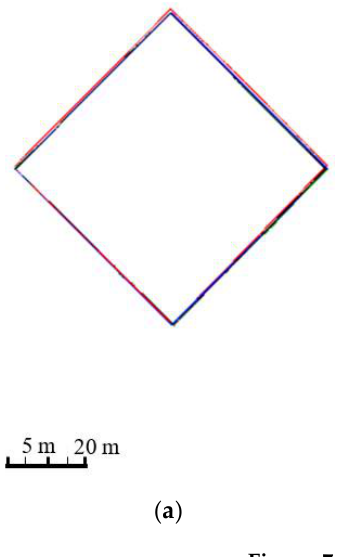
Figure 7. Reference and DR, GA1, GA2 estimated paths of vehicle F obtained in the course of conducting: ( a ) single test sample; ( b ) hundred test samples.